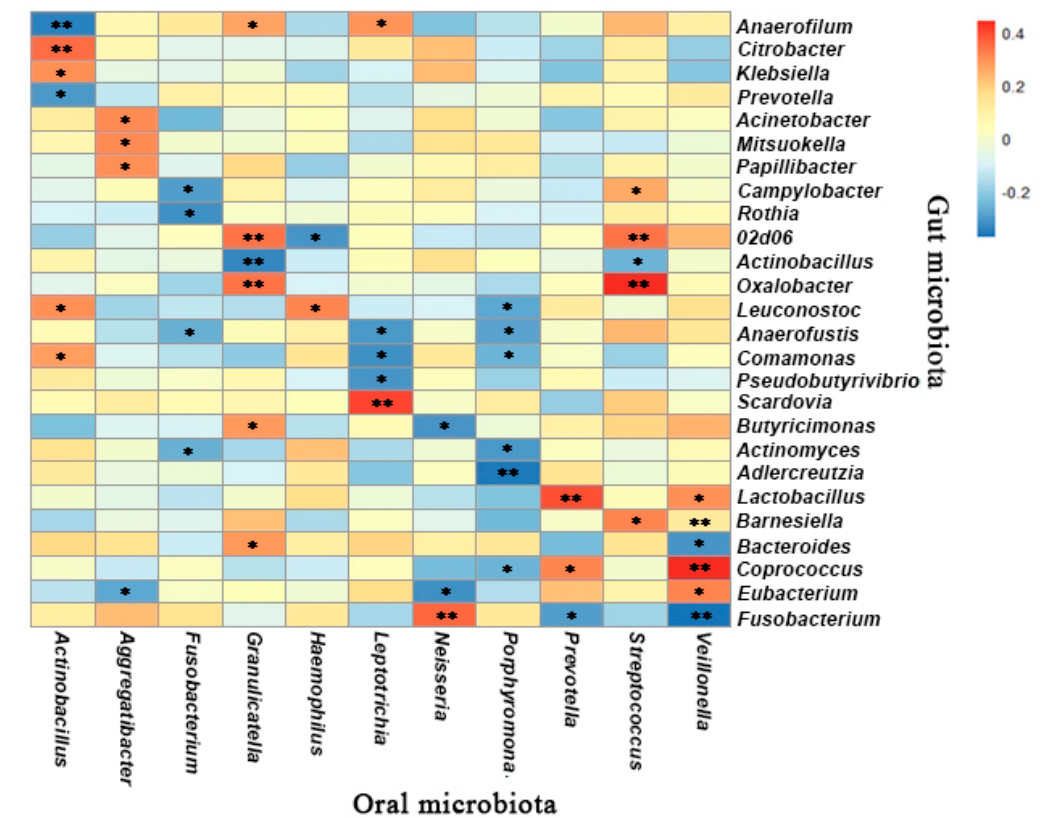
Figure 5. Genus level correlation heatmap between the oral microbiota and gut microbiota (* p < 0.05, ** p < 0.01; the p value was calculated using Pearson’s correlation).